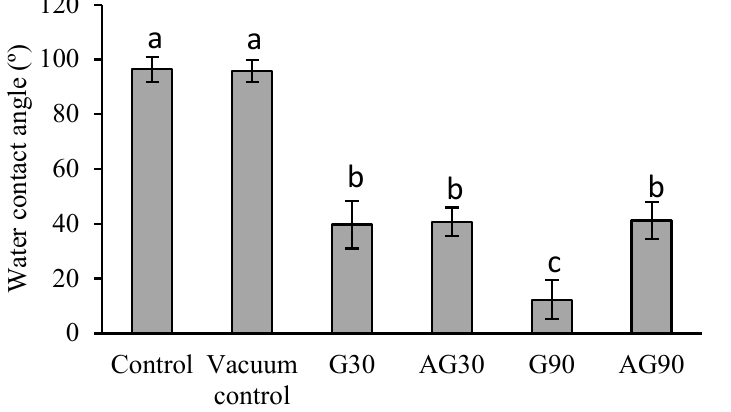
Figure 1. Water contact angle on the wheat seed surface of untreated (control), vacuum-treated seeds (vacuum control), and seeds treated in the CP glow regime for 30 s (G30) or 90 s (G90) and afterglow regime for 30 s (AG30) or 90 s (AG90). Displayed values are the mean ± SE of three replications. Different letters (a–c) indicate statistically significant differences among treatments according to Duncan’s test ( p < 0.05).